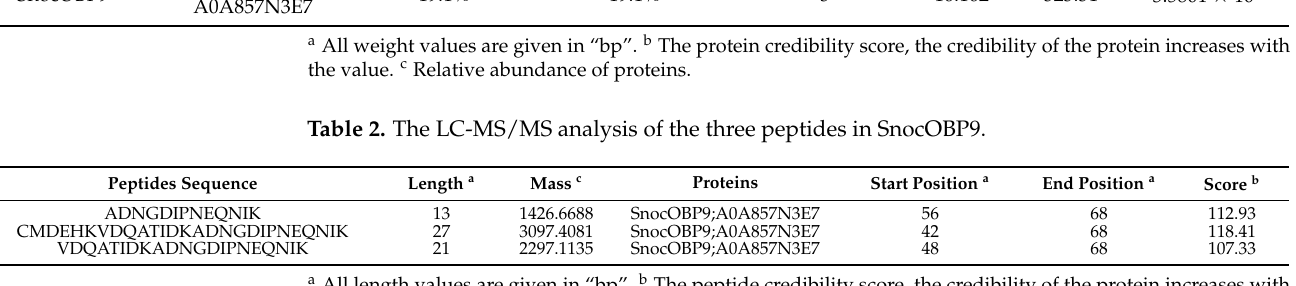
Table 2. The LC-MS/MS analysis of the three peptides in SnocOBP9.